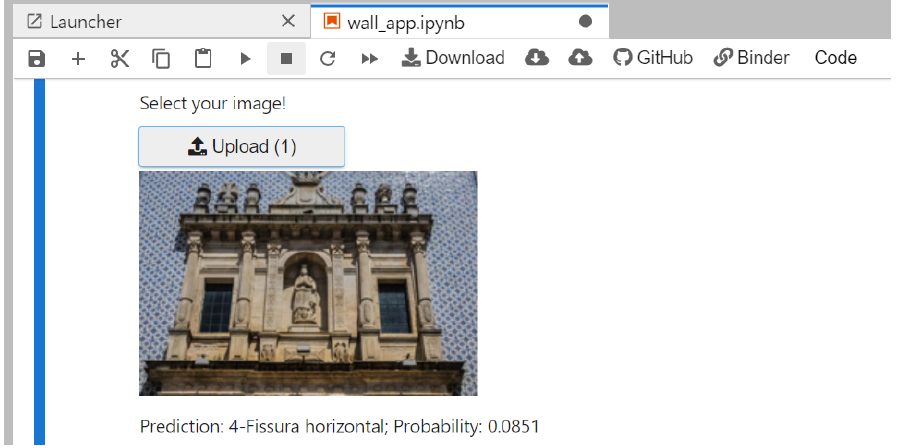
Figure 9. Example of inappropriate anomaly classification by means of DL model: horizontal crack.